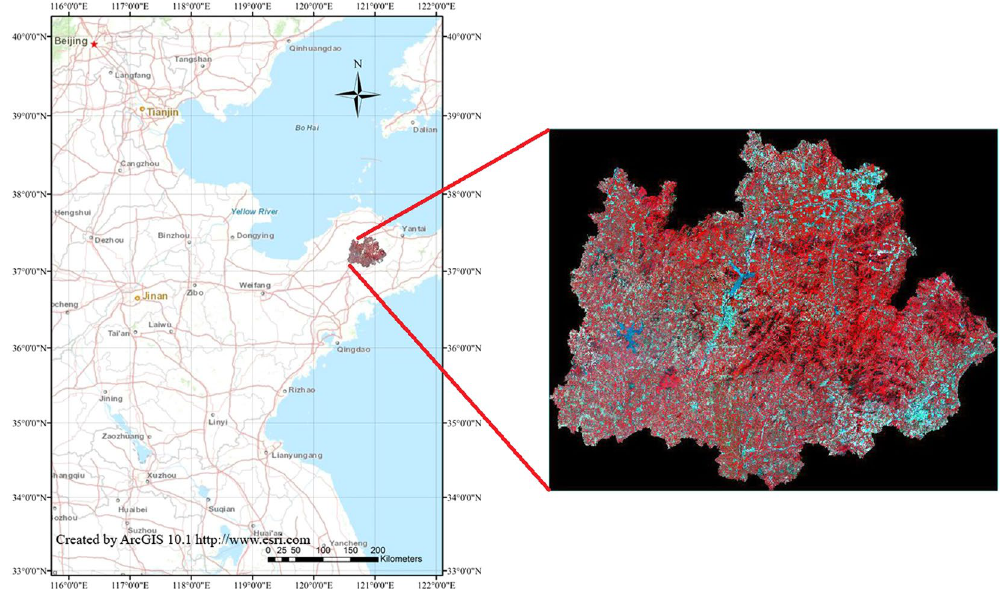
Figure 1. Location of the study area.